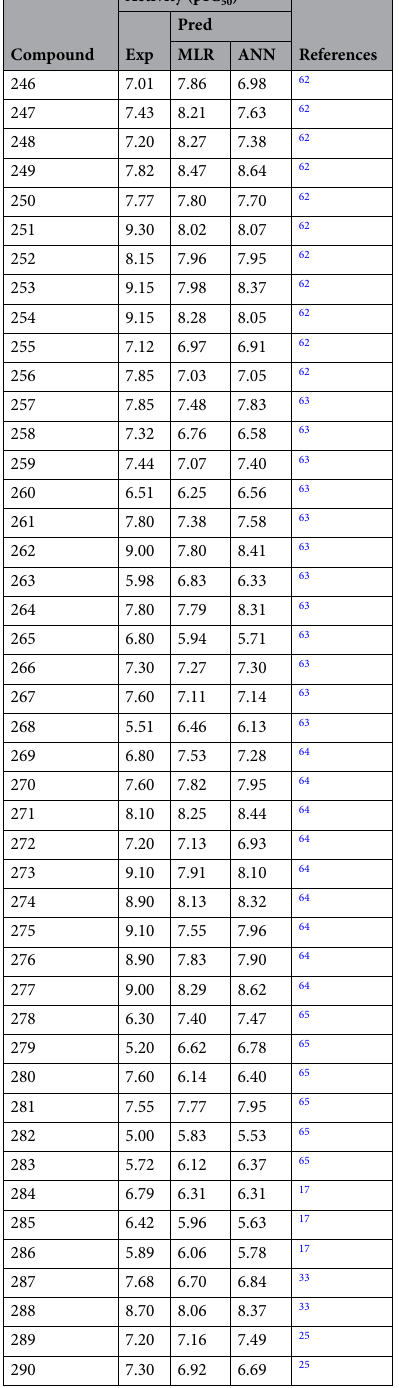
Table 9. The experimental pIC 50 values of 45 PI3Kγ inhibitors used as a validation set and corresponding predicted values for them based on the MLR and ANN